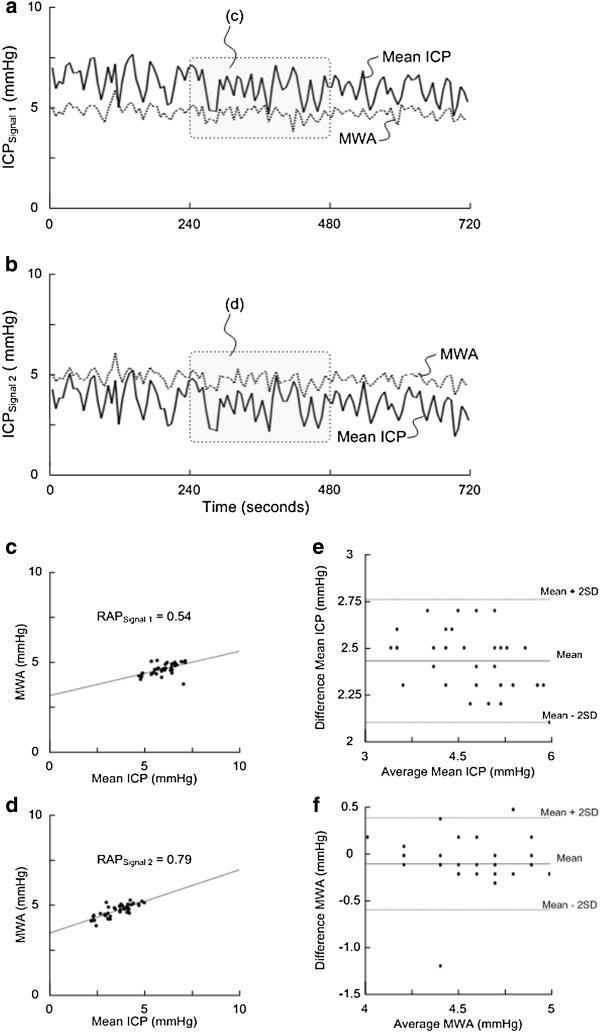
Illustration of the method of determining the RAP in patient 1. Following automatic identification of the cardiac induced single intracranial pressure (ICP) waves, the mean ICP and mean wave amplitude (MWA) are determined for every 6-s time window. Trend plots of mean ICP and MWA determined during the same 6-s time windows are shown for Signals 1 (a) and 2 (b) over a 12 min period (representing three 4-min periods, and 120 6-s time windows). For Signal 1 (a) the average (±standard deviation) of mean ICP was 6.1±0.7 mmHg and of MWA 4.7±0.3 mmHg; while for Signal 2 (b) mean ICP 3.6±0.7 mmHg and MWA 4.8+0.3 mmHg (mean difference of ICP −2.4±0.2 mmHg; mean difference of MWA 0.09±0.17 mmHg). RAP is determined as the Pearson correlation coefficient between mean ICP and MWA during subsequent 4 min periods (representing 40 6-s time windows). For the 20 patients in this study, we compared the RAP values during the same 4-min periods for Signals 1 and 2. For the 4-min period shown here, RAP was 0.54 for Signal 1 (c) while 0.79 for Signal 2 (d). The difference in RAP during this 4 min period was related to the difference in mean ICP [mean ICP: 5.9±0.7 mmHg (Signal 1) vs. 3.5±0.8 mmHg (Signal 2)], while the difference in MWA was marginal [MWA: 4.6±0.3 mmHg (Signal 1) vs. 4.7±0.3 mmHg (Signal 2)]. This is further illustrated in a Bland-Altman [33] plot showing less agreement between mean ICP (e; mean difference = 2.43 mmHg; mean + 2SD = 2.76 mmHg; mean – 2SD = 2.10 mmHg), while higher agreement between MWA of Signals 1 and 2 (f; mean difference = −0.09 mmHg; mean + 2SD = 0.41 mmHg; mean – 2SD = −0.59 mmHg).